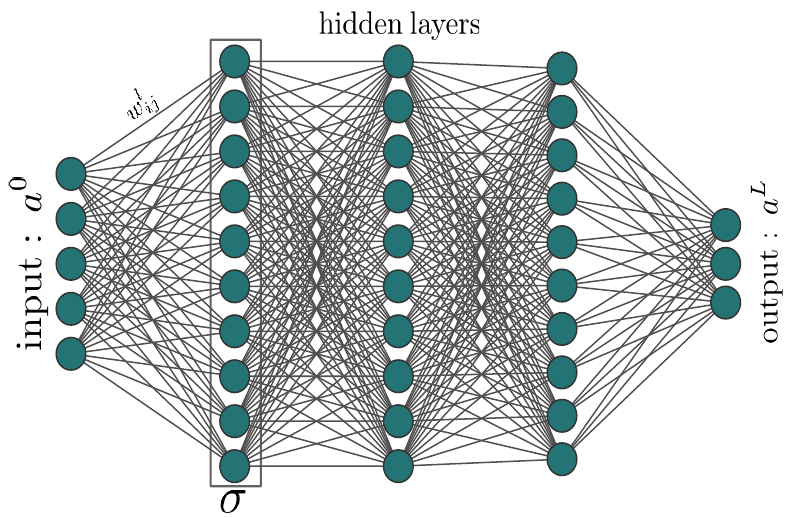
Figure 2. Structure of a deep neural network (or multilayer perceptron) with three hidden layers. Each neuron in the input layer receives a feature (or attribute) from the original dataset. The output layer generates a prediction that is compared, using a loss function, to the dependent variable within the original